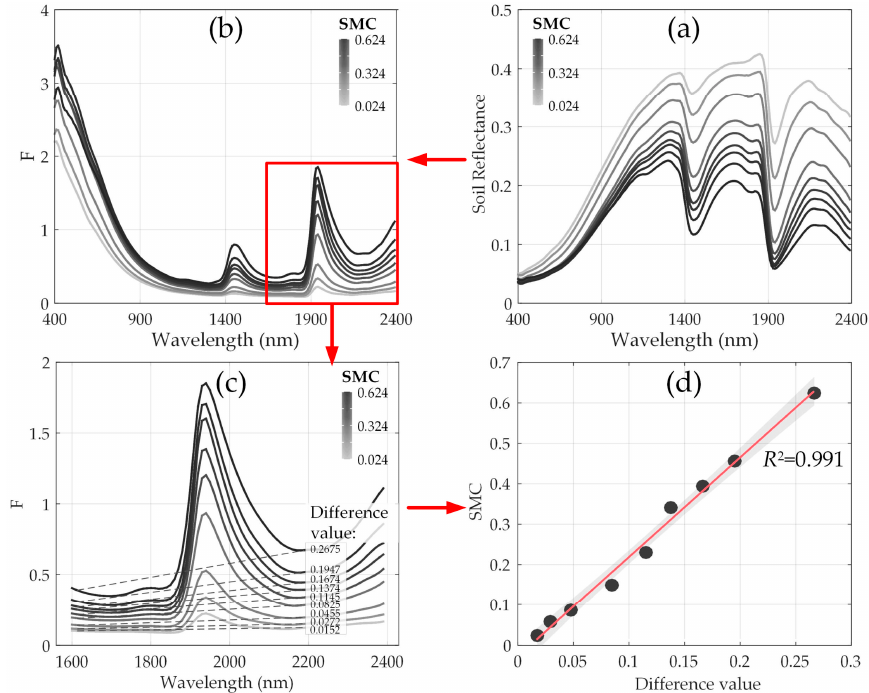
Figure 3. ( a ) Reflectance of Mollisol soil; ( b ) F value of Mollisol soil calculated by Equations (7) to (9); ( c ) Value of F 2190 − F 1610 ; ( d ) Di ff erence value and